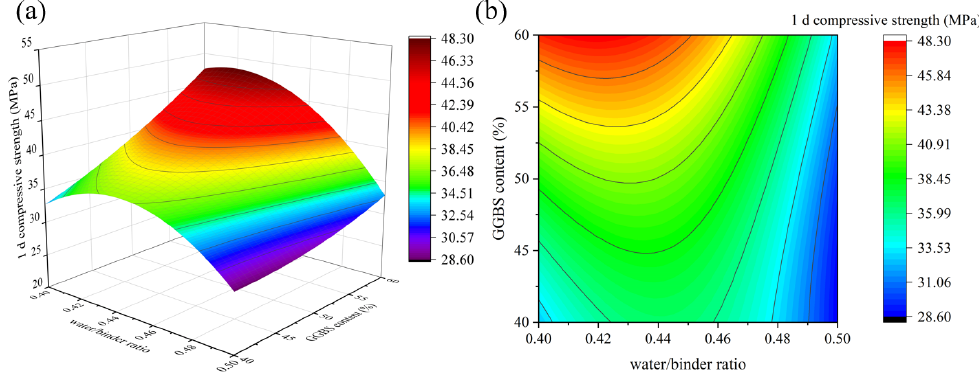
Figure 6. The interaction effect of SiO 2 /Na 2 O molar ratio and GGBS content on 1 d compressive strength: ( a ) 3D response surface; ( b ) contour diagram.